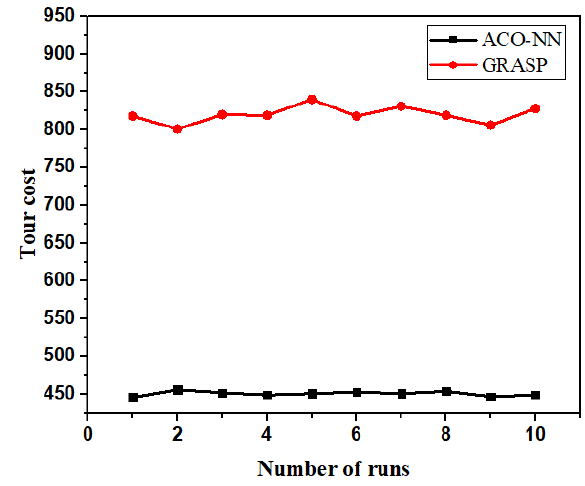
Figure 7. Comparison of ACO-NN with GRASP for Eil51 regarding optimal solution metric.